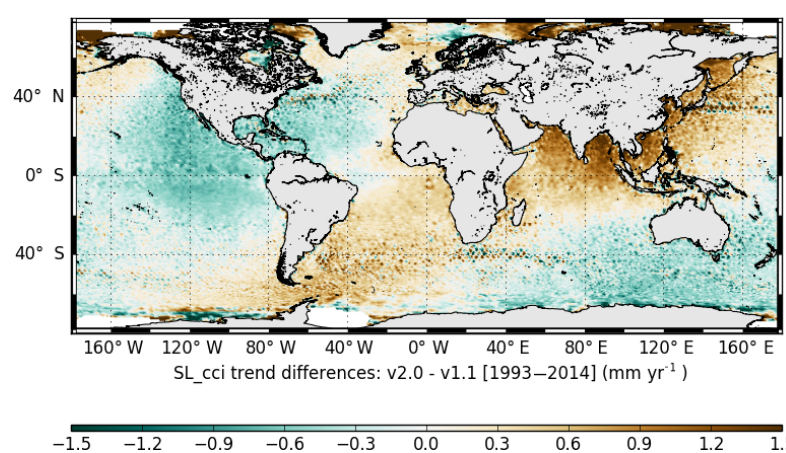
Figure 7. Regional mean sea level trend differences between the SL_cci ECV v2.0 and v1.1 during 1993–2014.